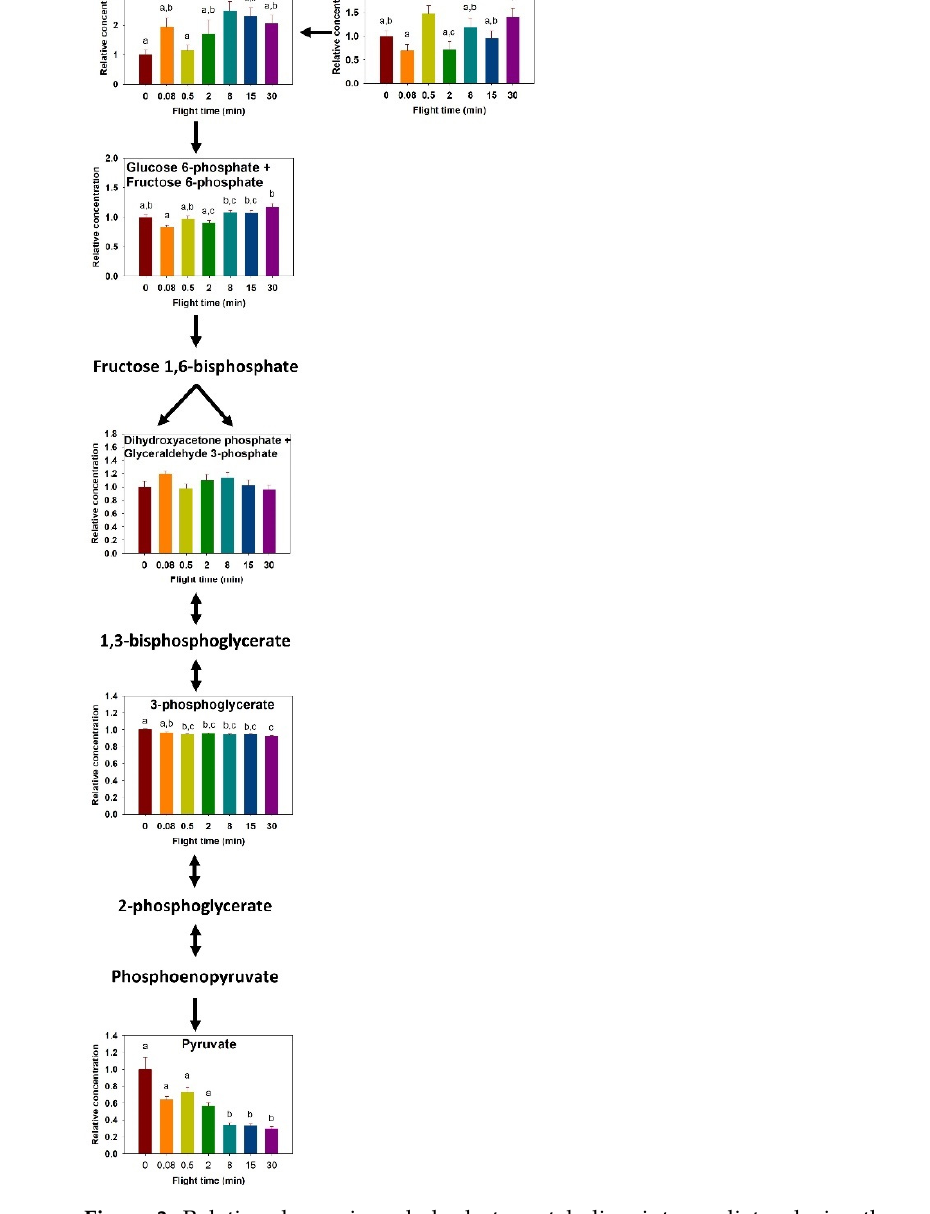
Figure 3. Relative change in carbohydrate metabolism intermediates during the progression of a 30-min flight in the thorax of the bumblebee Bombus impatiens . Colors correspond to flight times (red = 0 min, orange = 5 s, yellow = 30 s, green = 2 min, light blue = 8 min, dark blue = 15 min, purple = 30 min). Columns that do not share a letter are significantly different ( p < 0.05).